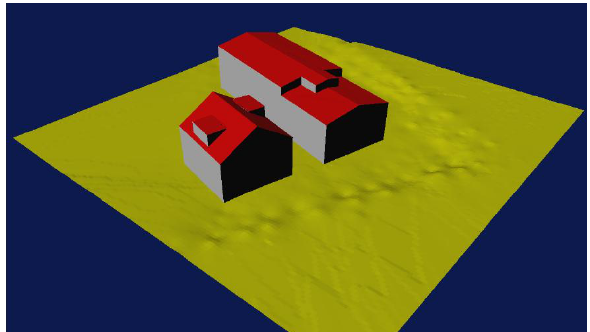
Figure 11 . Non/textured 3D-Model derived from UAV